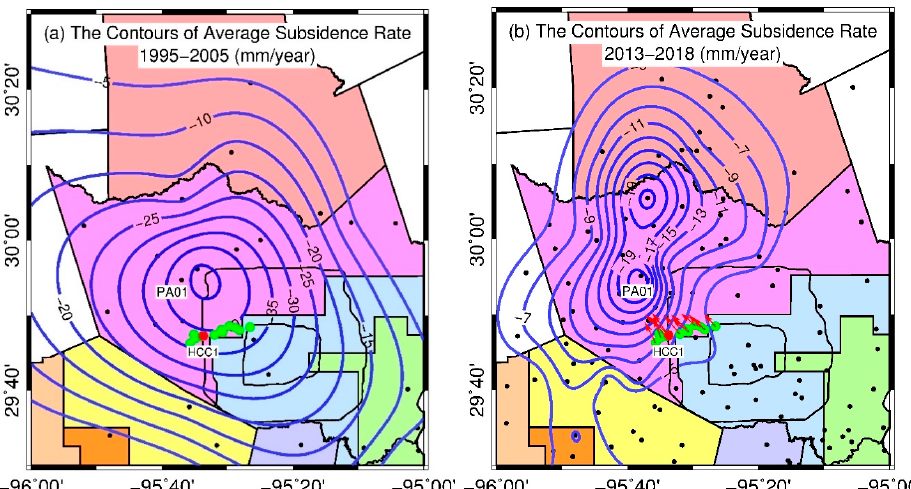
Figure 11. Contour maps showing GPS-derived subsidence in the Jersey Village area during two di ff erent periods: ( a ) 1995–2005 and ( b ) 2013–2018. Dark dots represent the locations of GPS stations that were used to develop the subsidence contours. Green dots represent the Long Point GPS Array. The color zones represent the di ff erent groundwater regulation zones [50]. The red vectors depict the horizontal ground motions that are same as the vectors exhibited in Figure